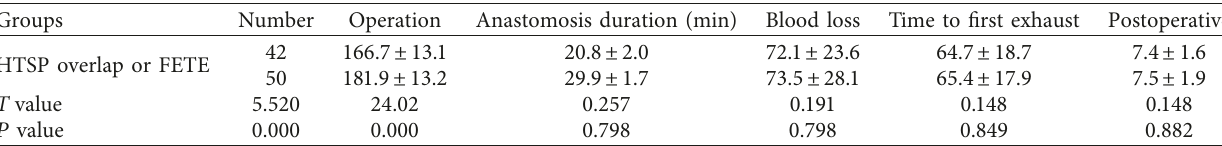
Table 2: Comparison of intraoperative and postoperative conditions between half-transected and self-pulling group and the traditional anastomosis group.